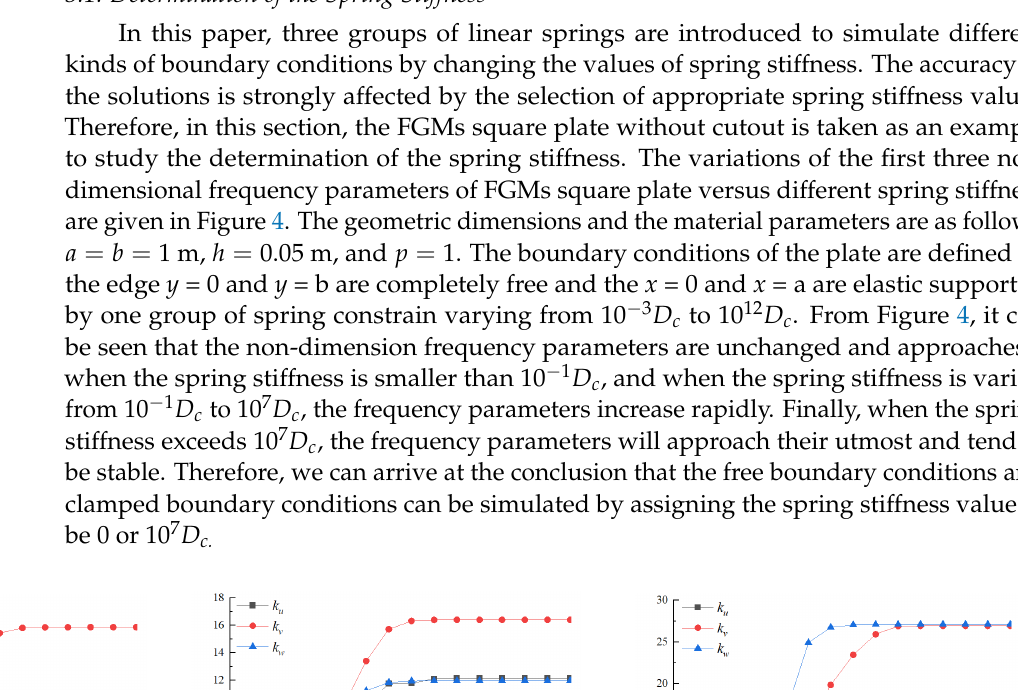
Figure 4. Variation of non-dimensional frequency parameters versus different spring stiffness for FGMs rectangular plate.